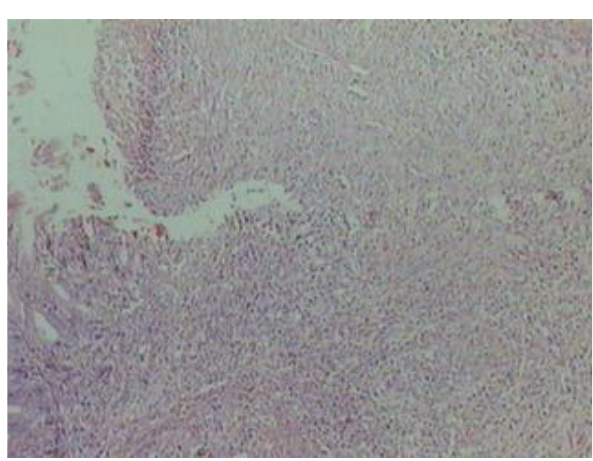
FIGURA 5 - Neoformação capilar discreta